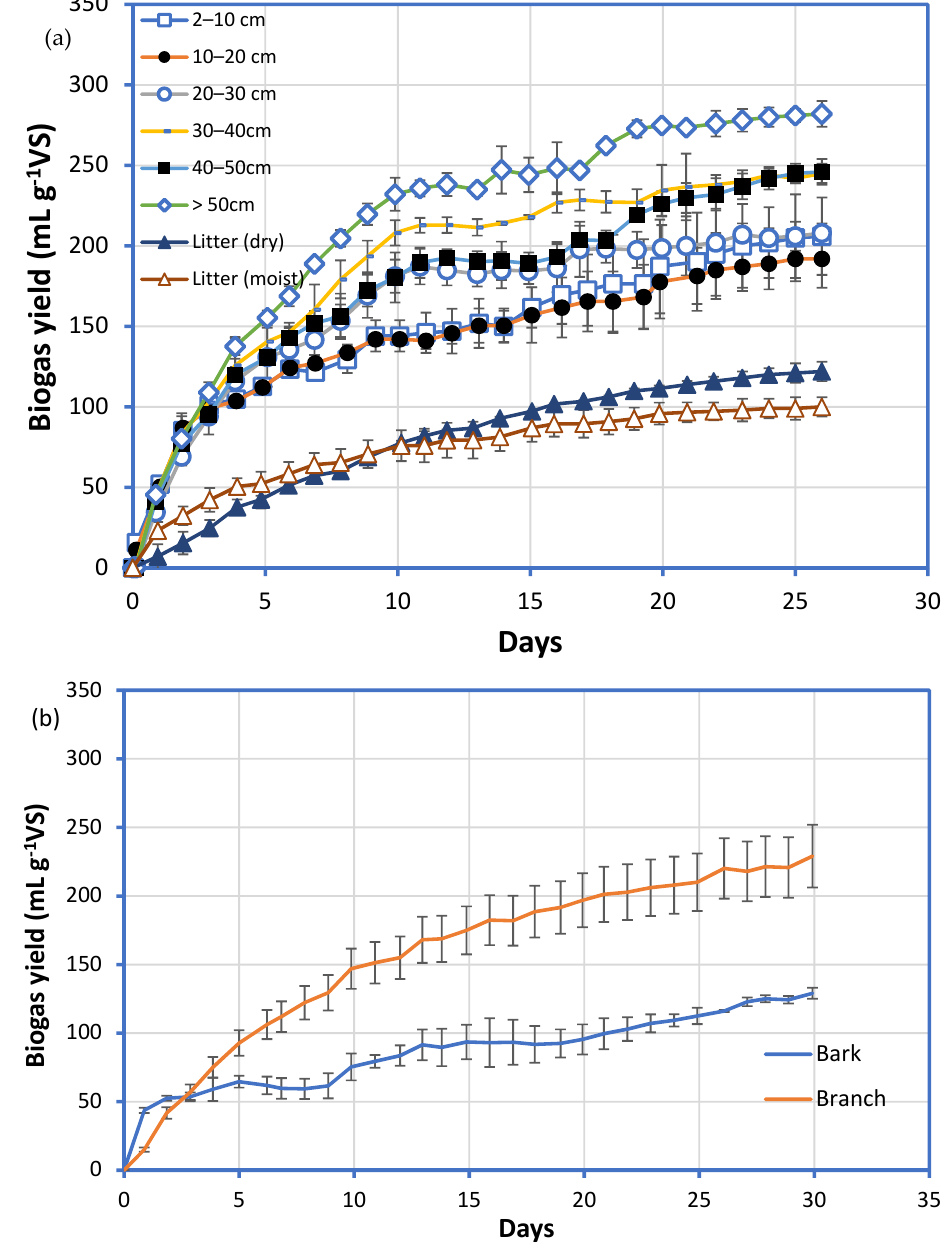
Figure 4. Cumulative biogas yield for ( a ) fresh pine needles and pine needle litter, and ( b ) pine bark and branches. Table 2. First-order kinetic constants and methane yield for fresh pine needles, pine needle litter, pine bark, and pine branches.